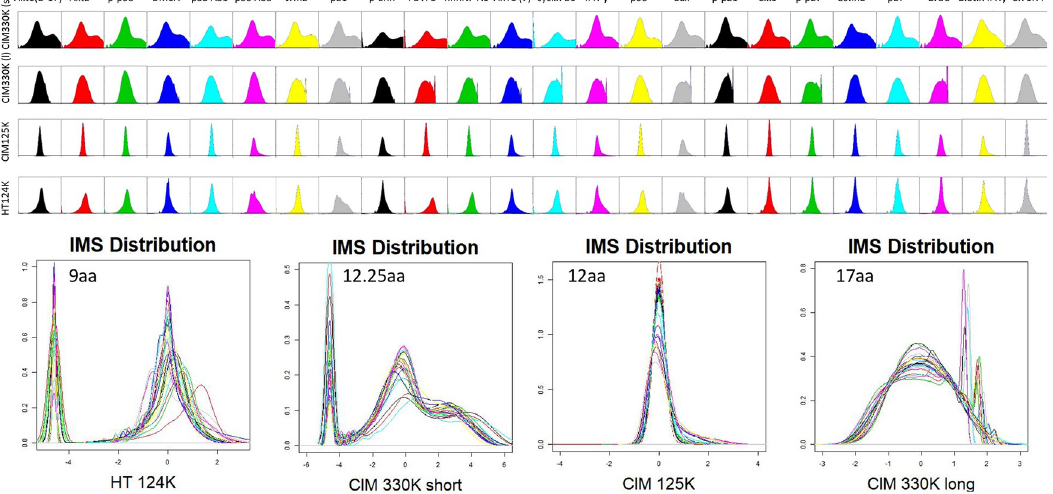
Fig 3. Data distribution for 24 monoclonals, for each peptide microarray library. Every peptide is shown as raw data for each of the 3 different peptide microarray libraries. Distribution kurtosis and 75 th percentile distributions are correlated to binding promiscuity.